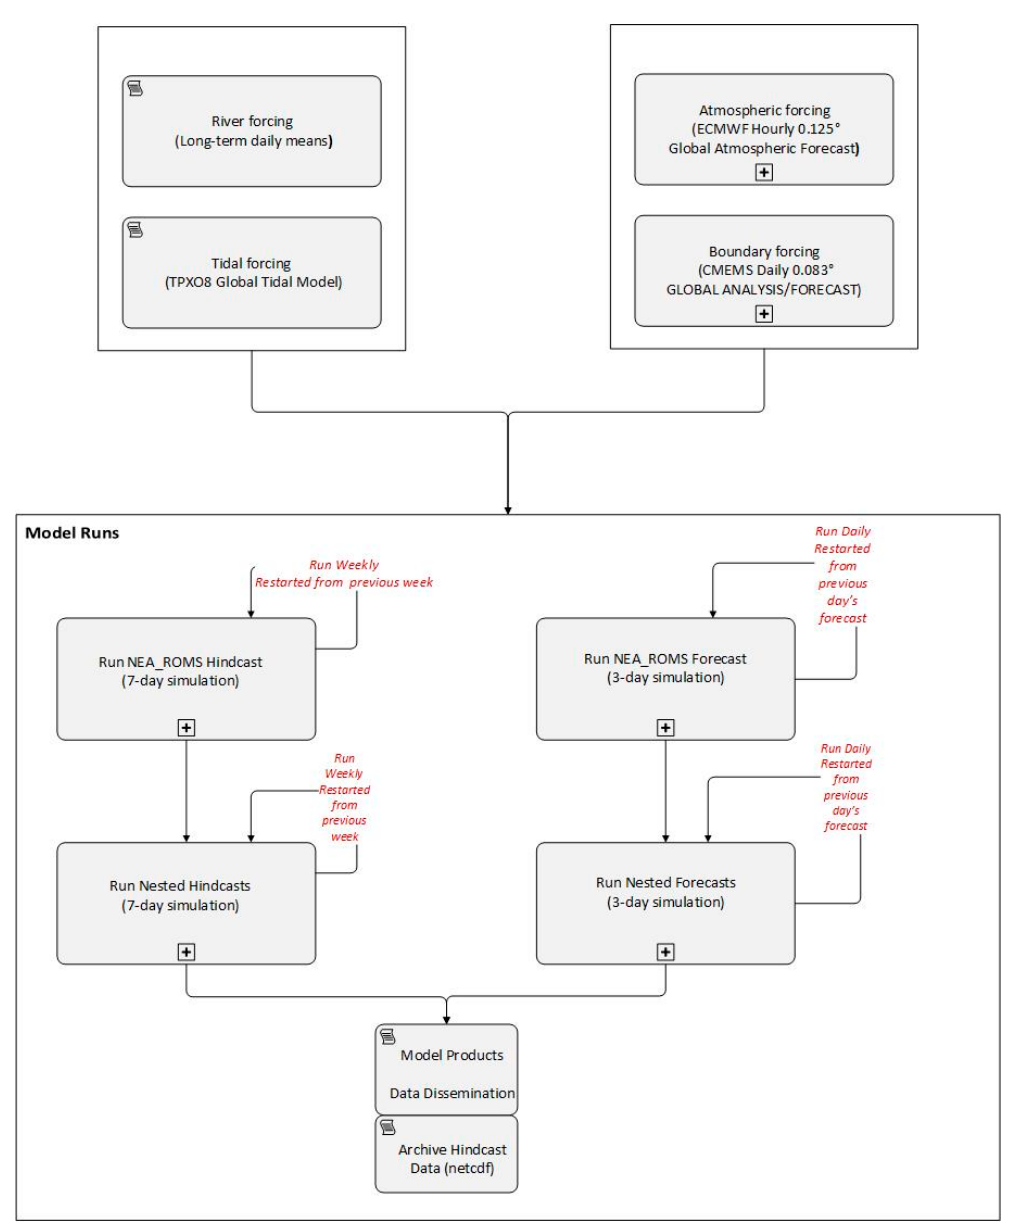
Figure 2. Schematic of the NEA_ROMS operational functioning during the simulation period.